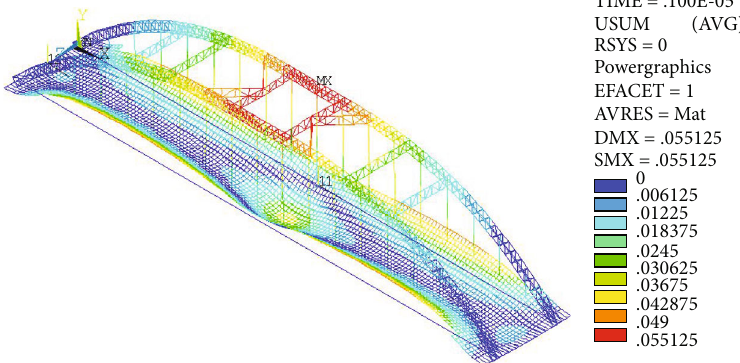
Figure 14: The overall displacement cloud map of arch bridge under case 5